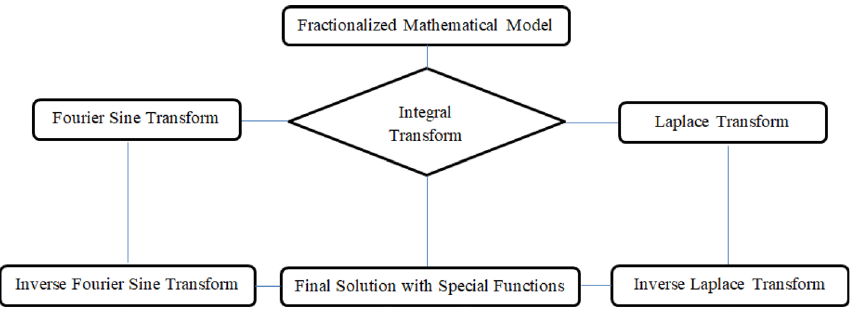
Figure 2. Flow chart for